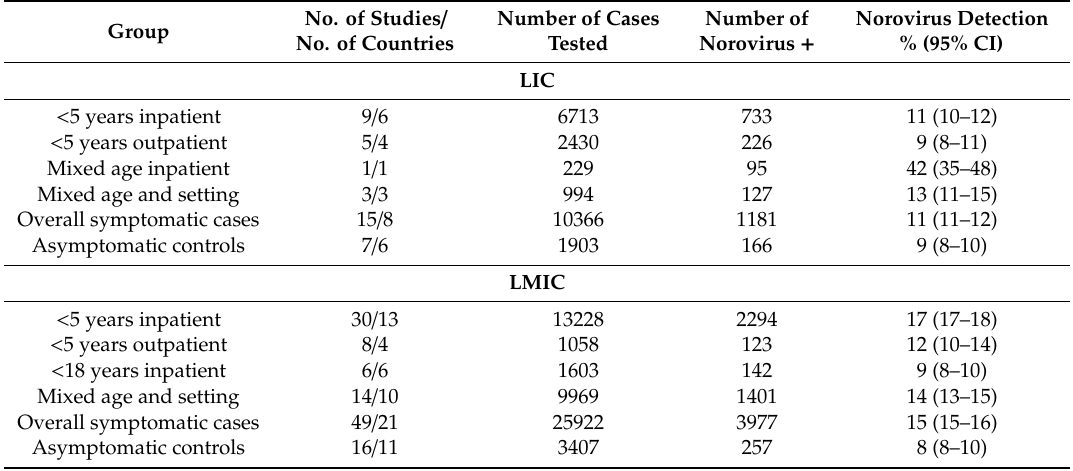
Table 1. The detection of norovirus in LIC and LMIC in gastroenteritis cases and asymptomatic controls.